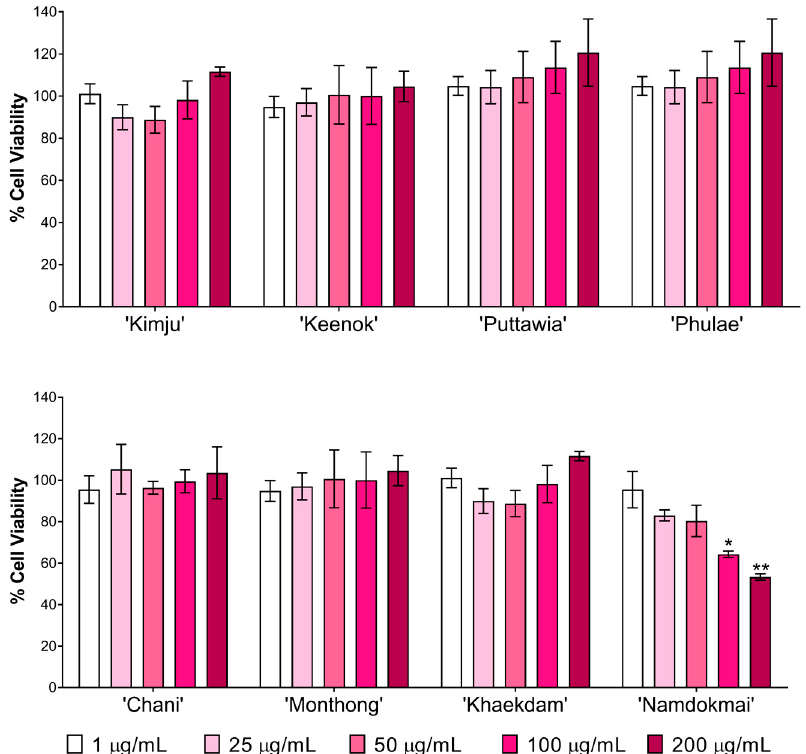
Figure 2. Effect of the eight fruit extracts on cell viability of human Burkitts lymphoma cells (Raji) determined by the water-soluble tetrazolium salt (WST-1) assay. Data are expressed as mean ± standard deviation (SD) of three experiments. The percentage of cell viability (% cell viability) was evaluated, and statistical significance was analyzed by Student’s unpaired t -test against its control group. *, p < 0.05 and **, p < 0.01.